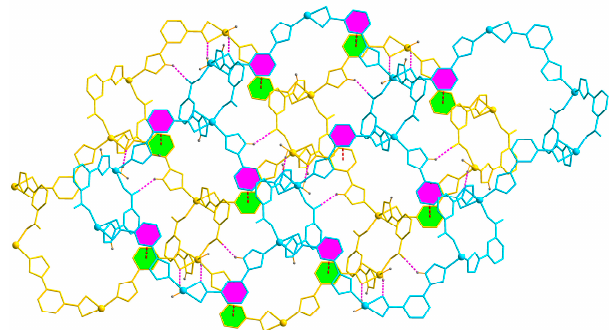
Figure 8. 3D supramolecular network structure of 2 linked by hydrogen bonds indicated by a dashed line and π - π stacking interactions of benzene groups.